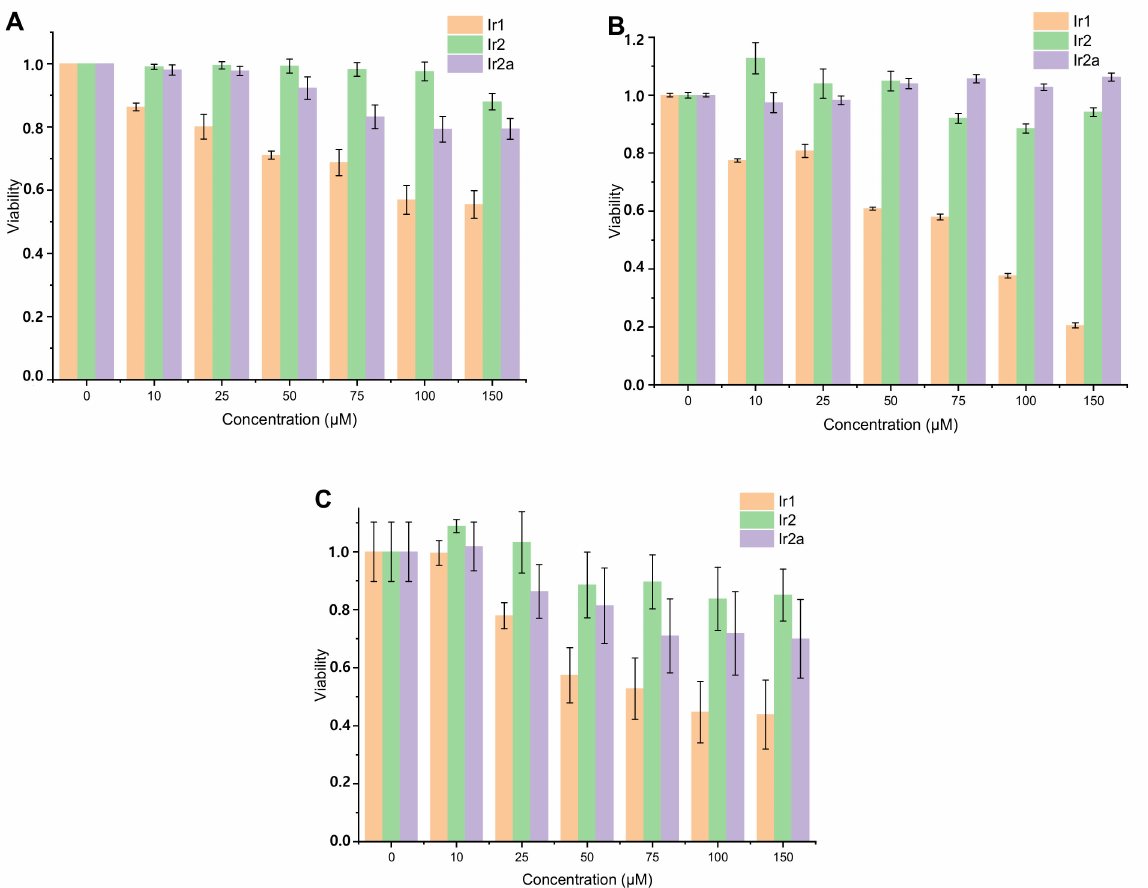
Figure 5. MTT assay of CT26 ( A ), HeLa ( B ), and CHO-K1 ( C ) cells after incubation with Ir1 , Ir2 , Ir2a for 24 h at different concentrations. Cell viability of control cells (without probe) was taken for 1. Mean ± standard deviation. N = 30 repetitions for CT26, 15 repetitions for HeLa, and 5 repetitions for CHO-K1